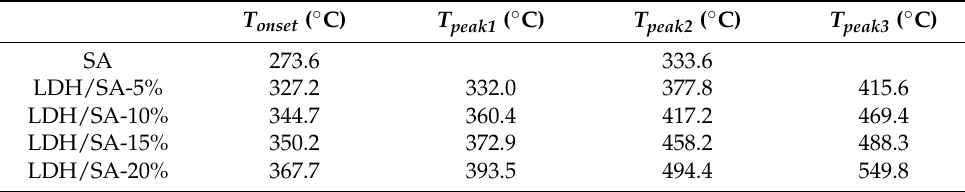
Table 2. The detailed DSC data of pure SA and LDH/SA